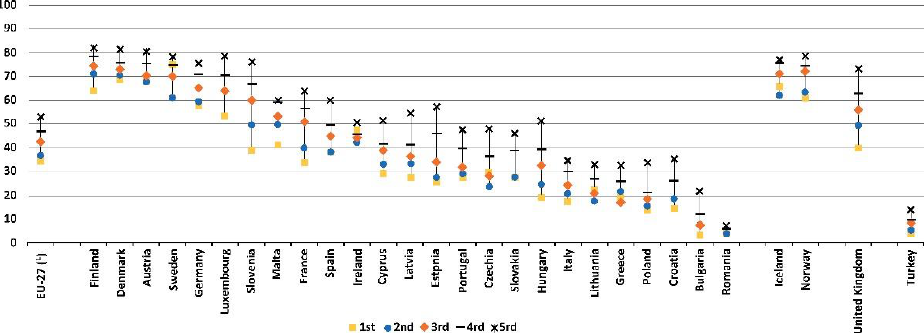
Figure 3. Practicing sport, fitness or recreational (leisure) physical activities at least once a week, by income quintile, 2014 [31].